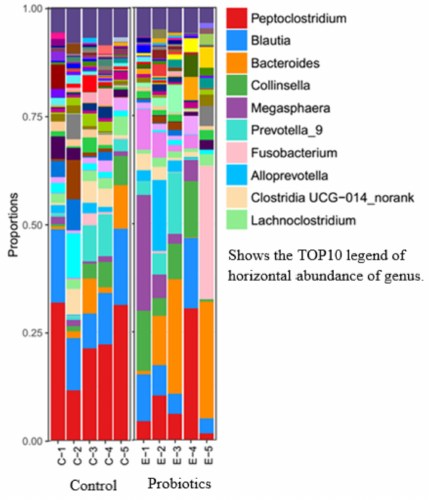
Figure 3. Relative abundance of the gut microbiota at the genus level.